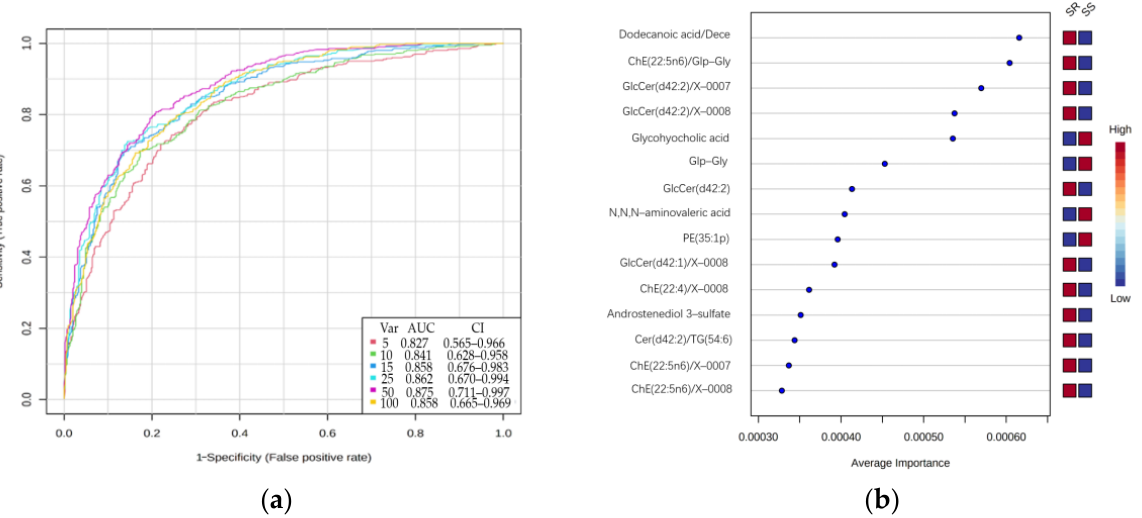
Figure 4. Identification of biomarkers for SS. ( a ): ROC of Monte Carlo models corresponding to the combination of 5 to 100 variables. ( b ): Relative average importance of the different variables chosen by the